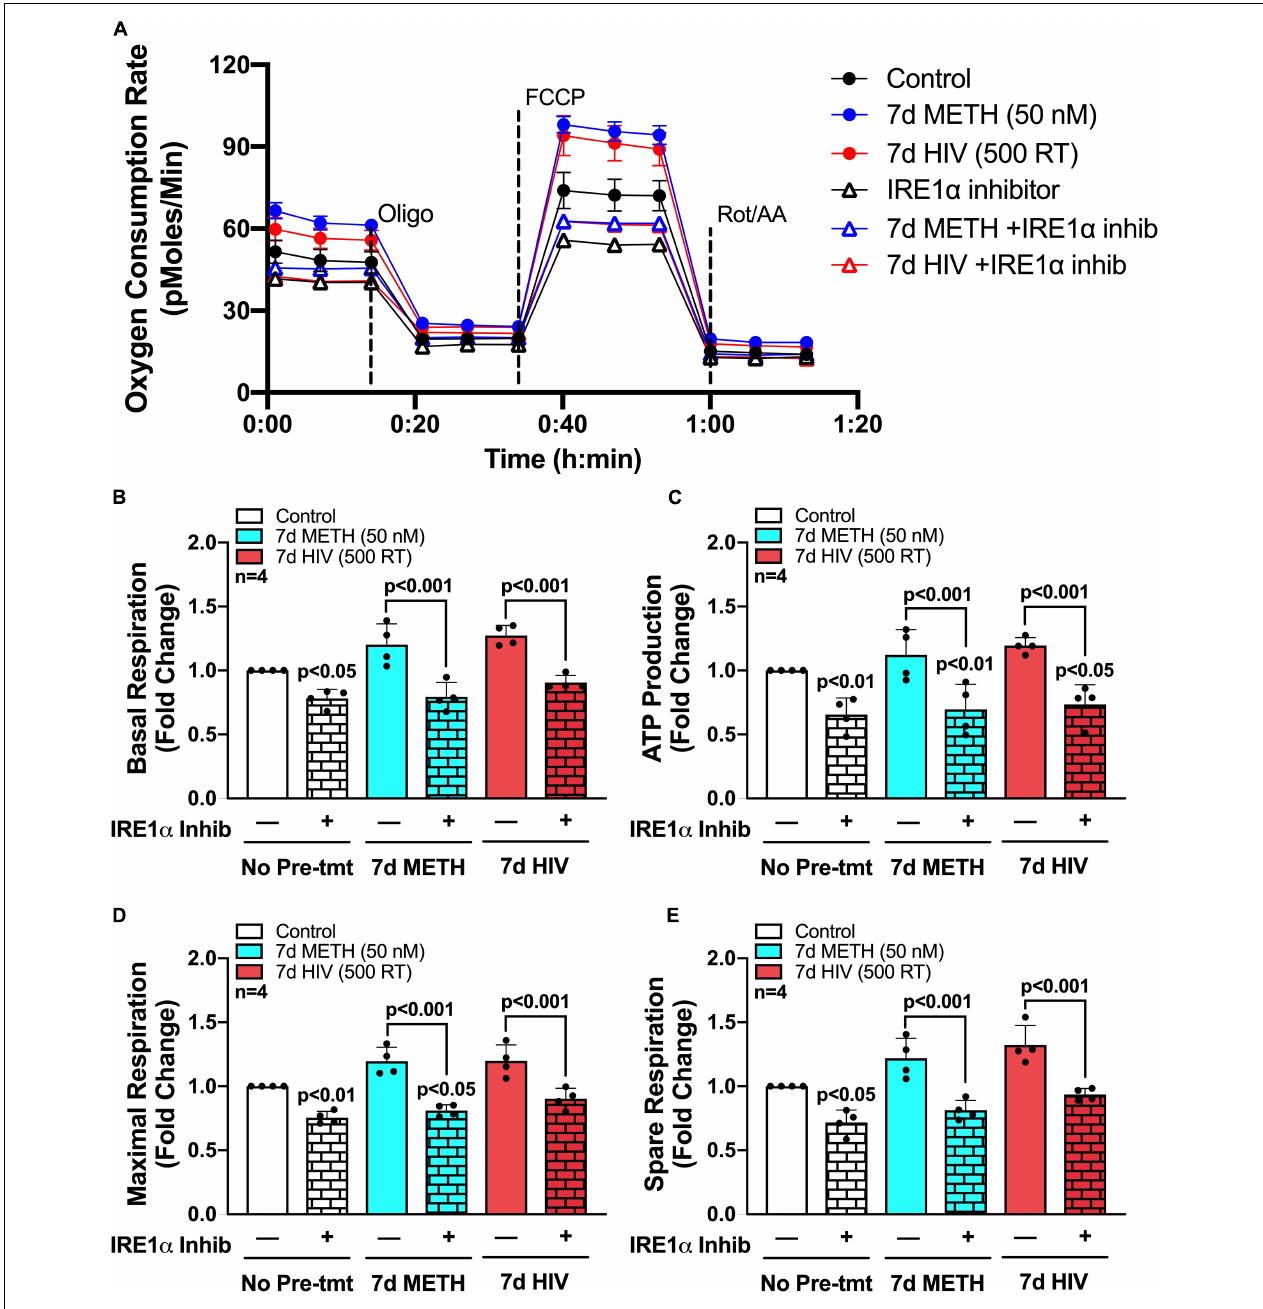
FIGURE 5 | IRE1 α inhibition can partially restore astrocyte metabolic function following HIV-1 infection and chronic METH exposure. (A–E) Astrocytes were treated with METH (50 nM; blue bars) or infected with pseudotyped HIV-1 (500 RT; red bars) for 7 days followed by IRE1 α pharmacological inhibition (STF-083010, 60 µ M) for 3 h prior to Seahorse Mito Stress Test. (A) Representative metabolic OCR profile tracing is illustrated from a single astrocyte donor. Compiled data quantifying fold changes in (B) basal respiration, (C) ATP production, (D) maximal respiration, and (E) spare respiratory capacity were graphed for statistical comparisons. Rescue experiments were performed twice in two separate biological donors to acquire four separate data sets. A minimum of six replicates were performed per experiment. Statistical significance was determined by one-way ANOVA followed by Tukey’s post hoc for multiple comparisons.